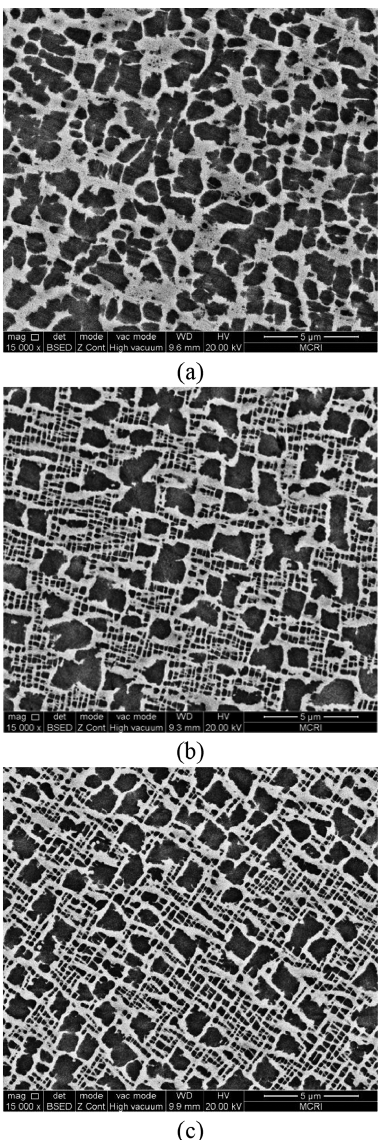
Figure 5: The morphology of γ ′ phase in non-HIPed and HIPed specimens (a) Cas; (b) H35 and (c)